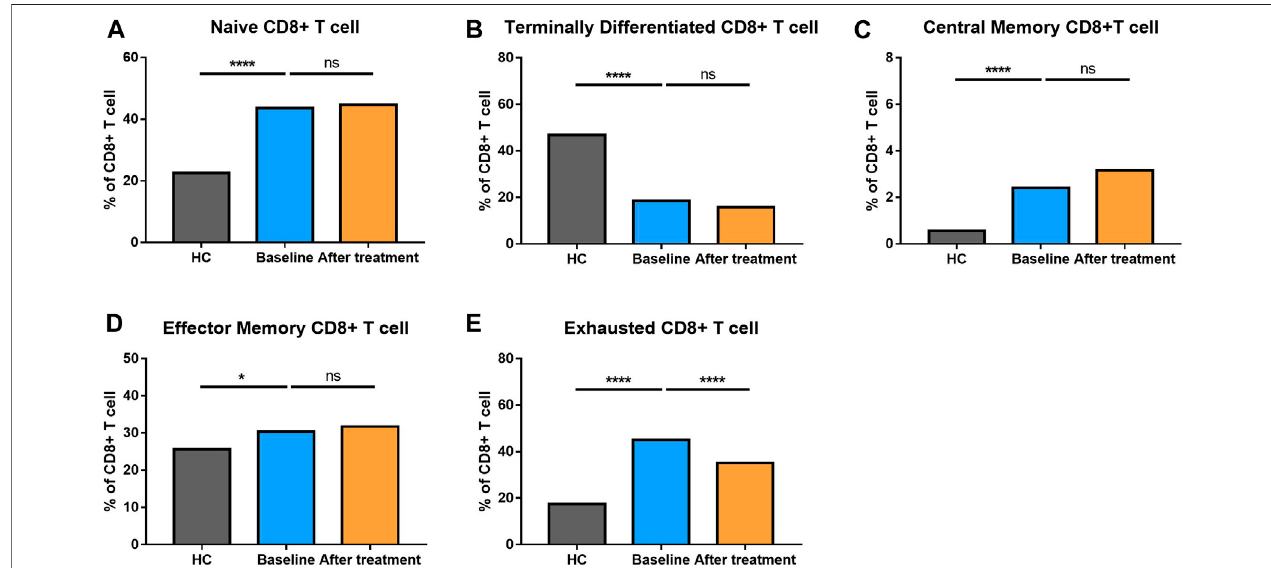
FIGURE 4 | Altered expression of CD8 + T cell subsets in AS patients after treated with secukinumab. The proportion of CD8 + T cell subsets measured by fl ow cytometry at baseline and after receiving secukinumab in AS patients. ns, not signi fi cant; *, p < 0.05; **, p < 0.01; ***, p ≤ 0.001; ****, p < 0.0001.